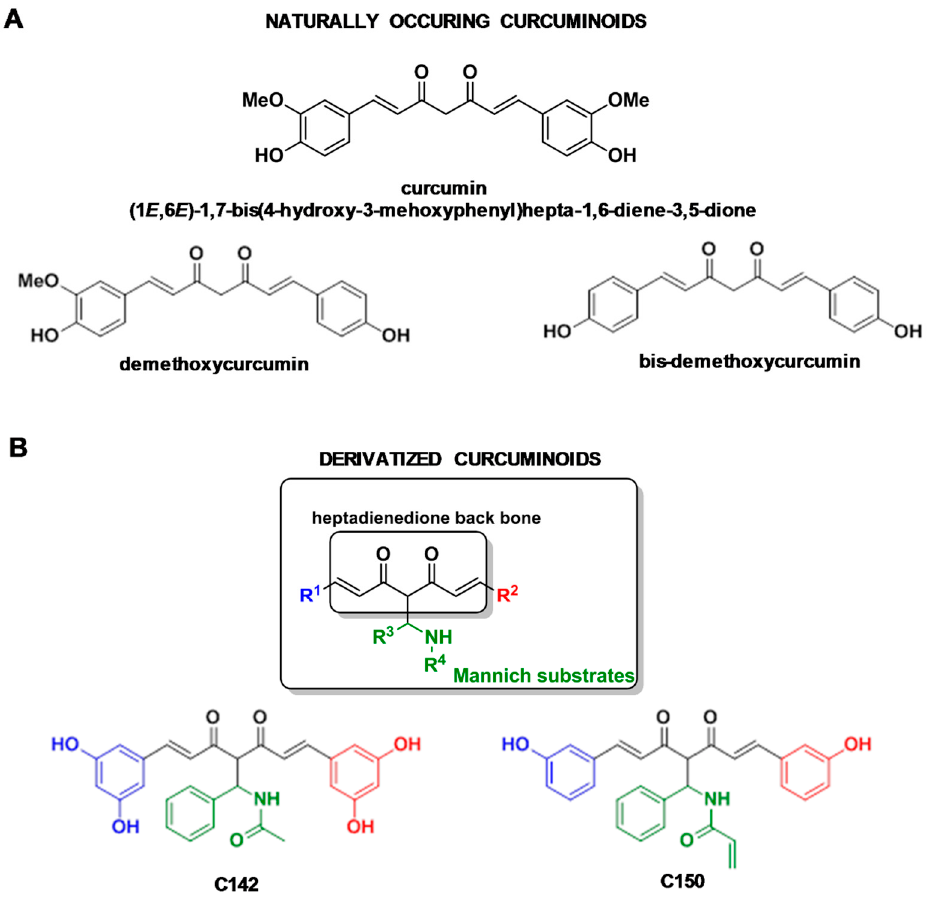
Figure 1. ( A ) Structures of naturally occurring curcuminoids and ( B ) structures of Mannich curcuminoids C142: N -((E)-5-(3,5-dihydroxyphenyl)-2-((E)-3-(3,5-dihydroxyphenyl)acryloyl)-3-oxo-1-phenylpent-4-en-1-yl)acetamide and C150: N -((E)-5-(3-hydroxyphenyl)-2-((E)-3-(3-hydroxyphenyl)acryloyl)-3-oxo-1-phenylpent-4-en-1 yl)acrylamide.